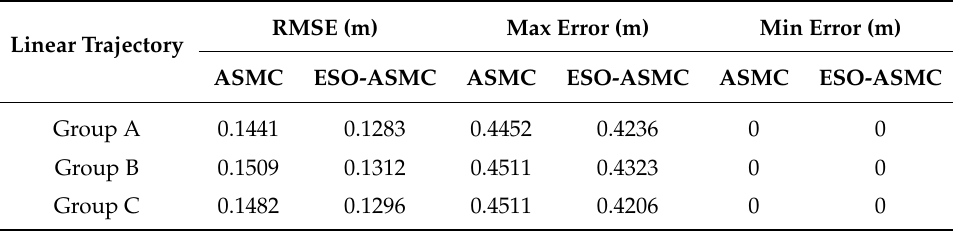
Figure 8. Velocity tracking errors. ( a ) Linear velocity tracking error. ( b ) Angle velocity tracking error. Table 4. Experimental results comparison of ASMC and